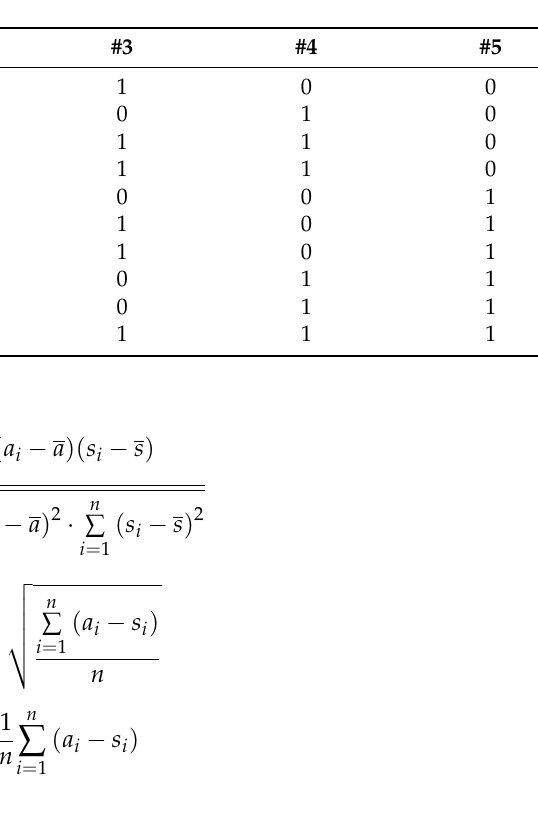
Table 3. Score table of product combinations when optimal agreement level is